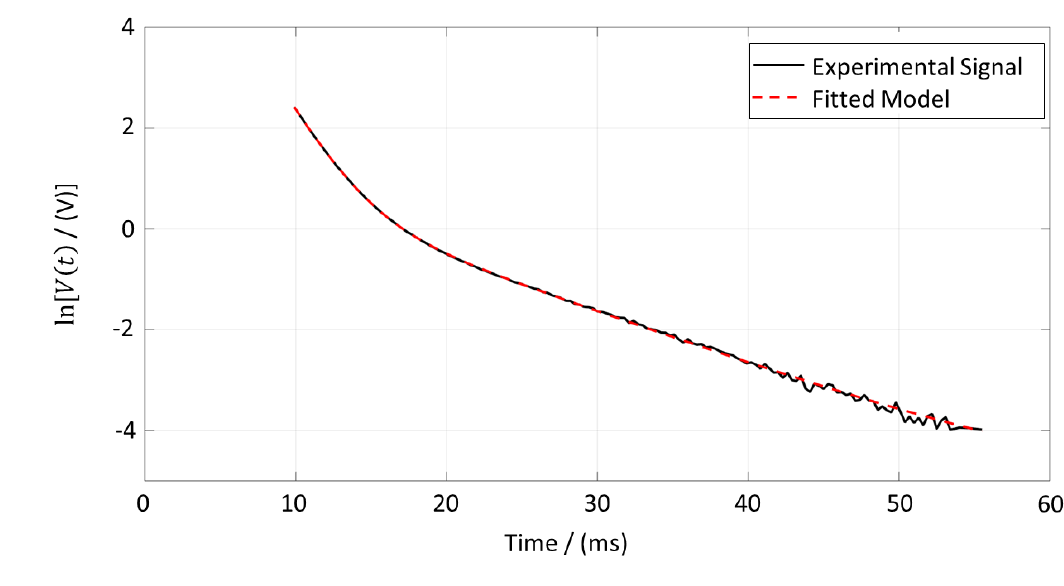
Figure 6. An example model fit, grey cast iron 20 mm thickness and 12 mm lift-off (RMSE =